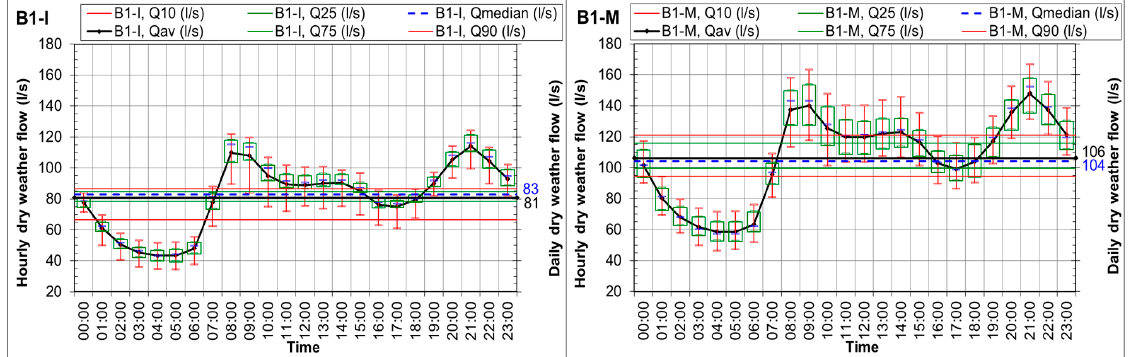
Figure 4. Hourly and daily dry weather flow statistics for weekdays in section B1-I and B1-M.